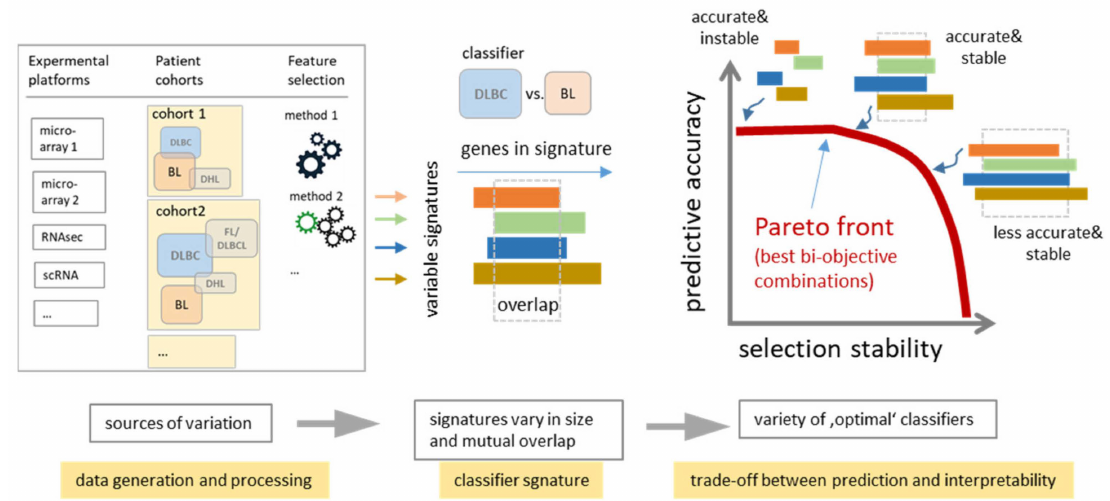
Figure 9. Extracting classifiers as a trade-off between prediction accuracy and stability classifiers for the same classification task (e.g., BL versus DLBCL) can vary owing to many reasons (e.g., mea- surement platforms, size and composition of test cohorts, data processing methods) resulting in “instability” of marker signatures due to varying size and composition. Bi-objective optimization be- tween prediction accuracy and stability can be understood as “Pareto”-front representing a manifold of optimal combinations along a curve indicating that considerable gain in stability (and thus consent between the signatures supporting their interpretability) can be achieved virtually without loss of prediction accuracy (the schematic view is adapted from